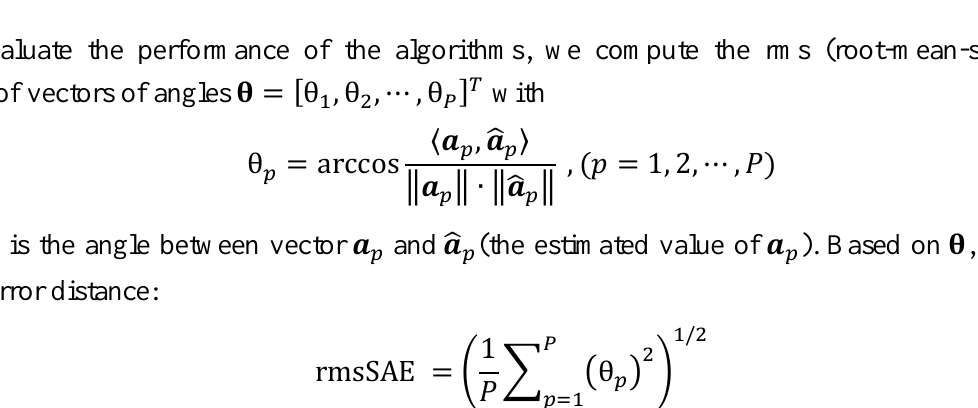
Figure 7. The proportion of each material in the rural